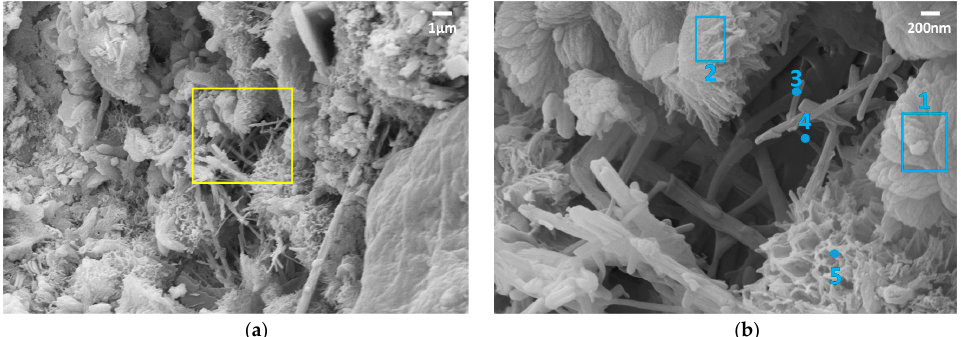
Figure 10. The images of SEM analysis (GONF-combined cement paste with 0.05% GONF at 7 days). ( a ) SEM image with 5000 X magnification; ( b ) SEM image with 10 kX magnification.